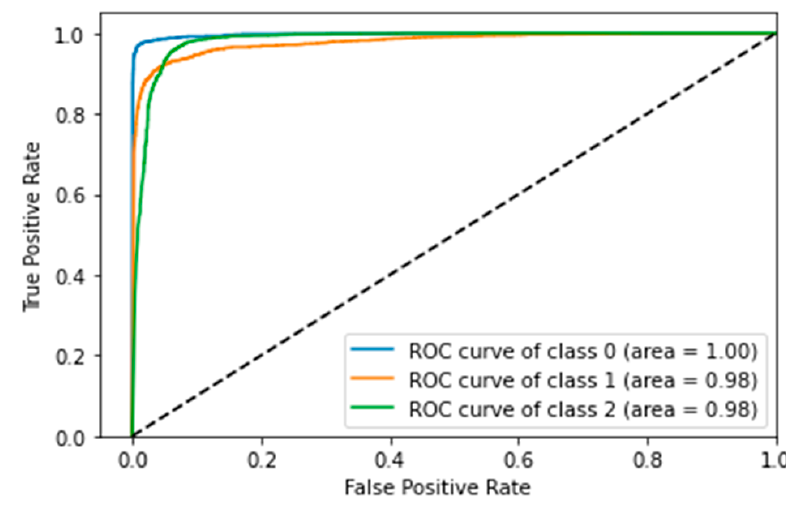
Figure 16. ROC curve for Xception model.